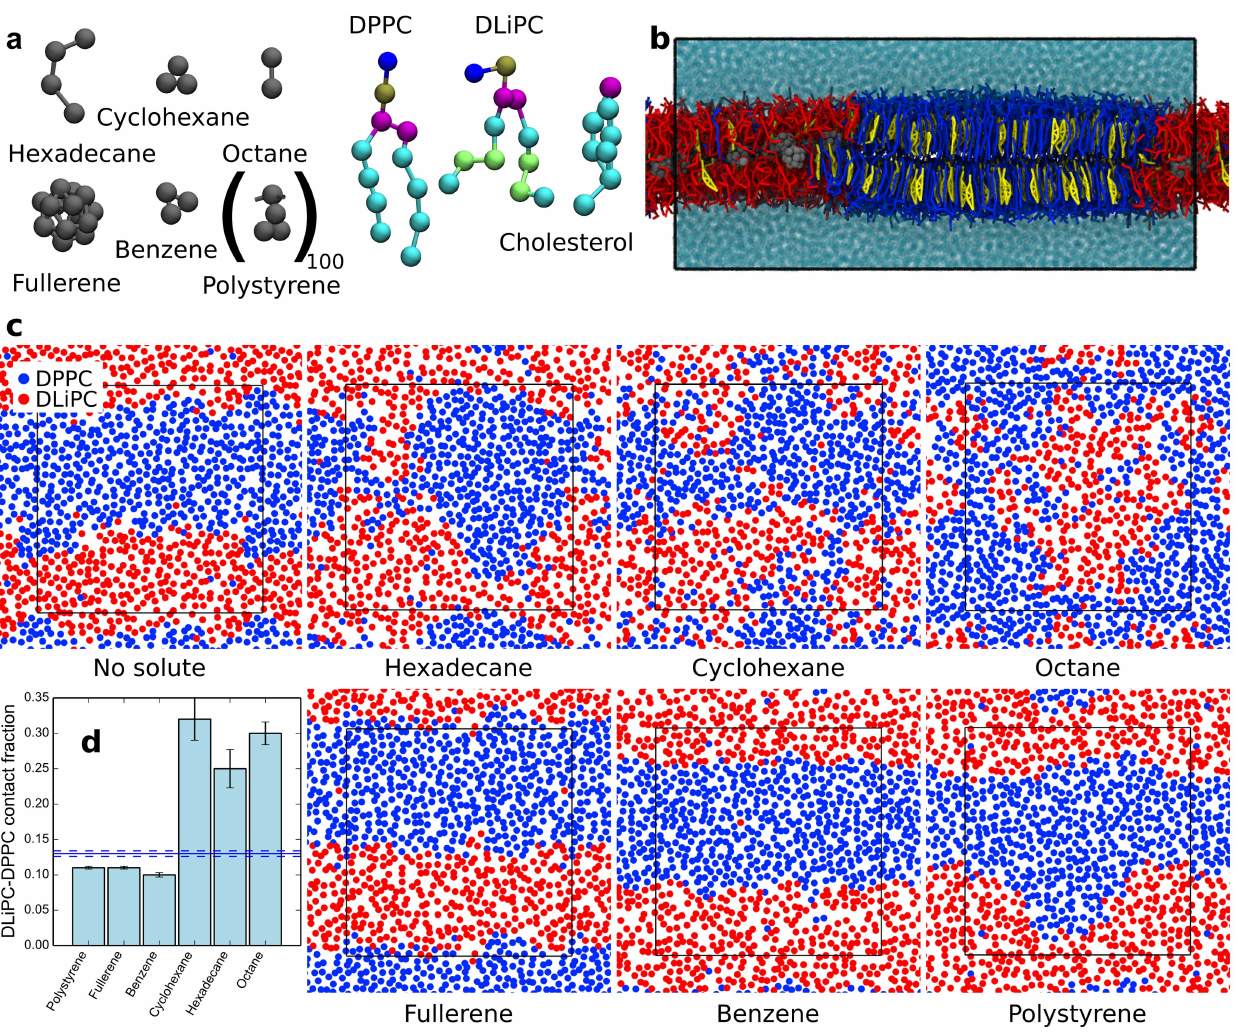
Figure 1. Effect of hydrophobic compounds on the stability of membrane domains. (a) MARTINI models of the hydrophobic solutes chosen for this study (colored in gray), phospholipids and cholesterol. (b) Side view of the phase separated membrane in the presence of fullerene at 295 K; DPPC is colored in blue, cholesterol in yellow, and DLiPC in red. (c) Top view of membrane systems with and without solutes (295 K, high solute concentration). Only one leaflet is displayed, and only one particle per lipid is shown (phosphate group), in red for DLiPC and in blue for DPPC. Solutes, cholesterol, and water are omitted for clarity. (d) DLiPC-DPPC contact fraction for the same systems; the solid blue line is for the case without solutes, the dashed lines are error